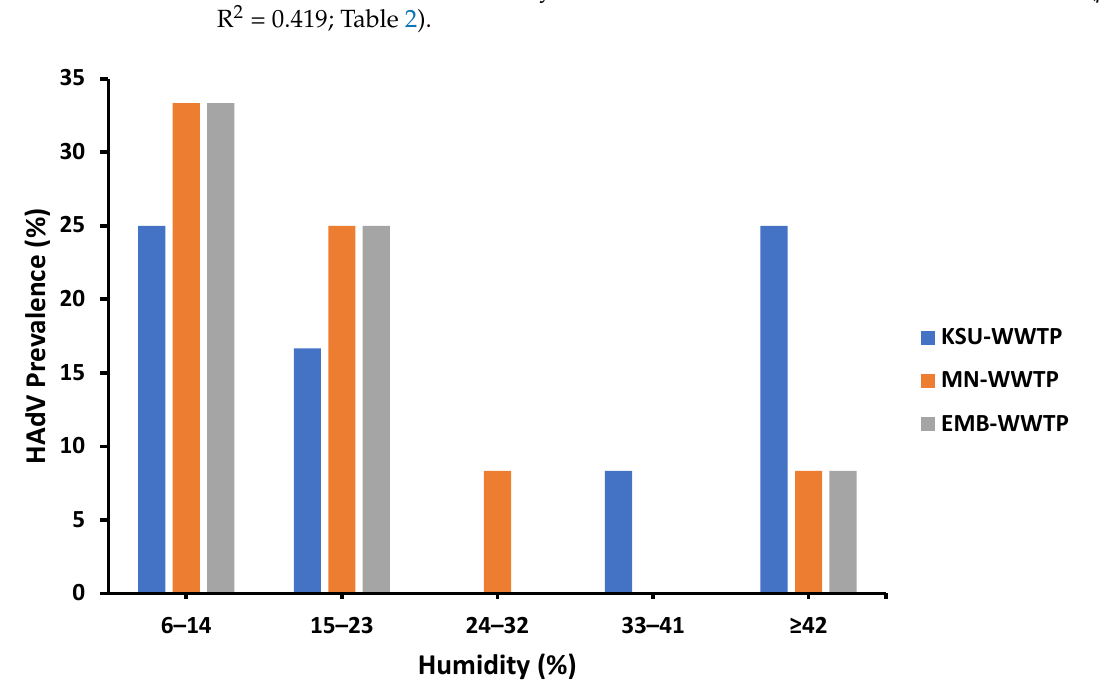
Figure 7. Impact of humidity variation on the HAdV prevalence (%) in different sampling areas.